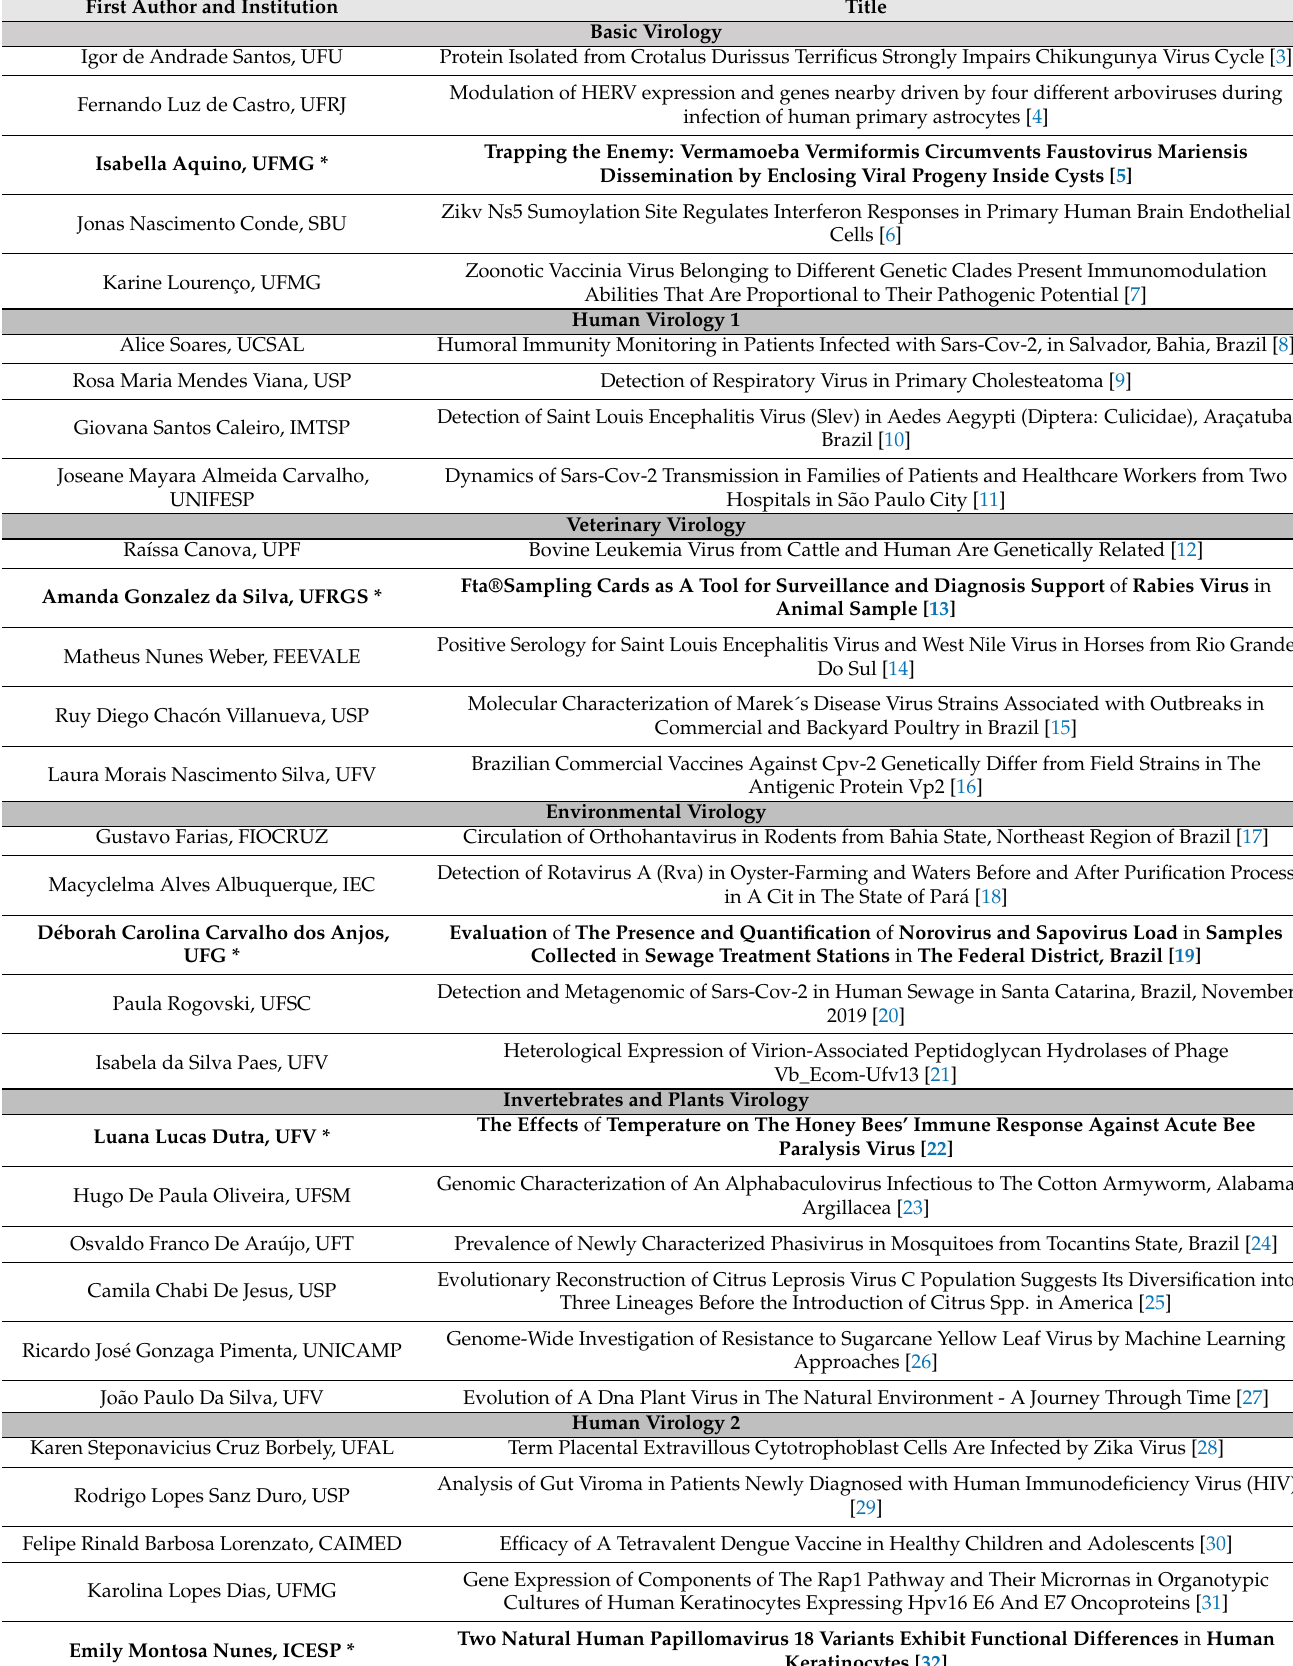
Table 2. Oral presentations at the 31st Brazilian Society for Virology Congress and 15th Mercosur Virology Meeting. First Author and